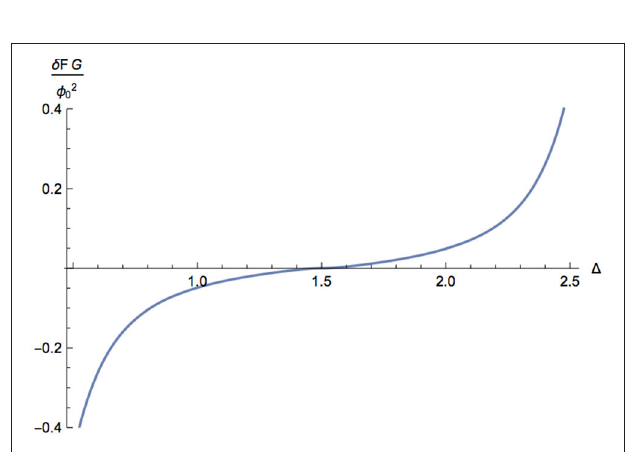
FIGURE 2 | The change in the renormalized free energy for 1 2 < 1 < 5 2 .